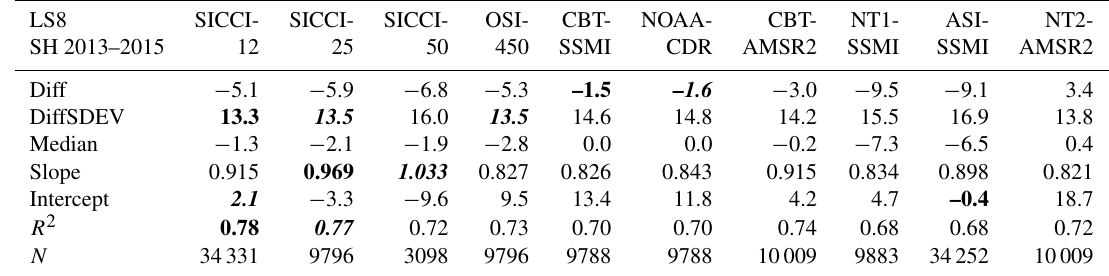
Table 7. Summary of statistical parameters shown in Fig. 4. See Table 5 for an explanation of the parameters given. LS8 SICCI- SICCI- SICCI-